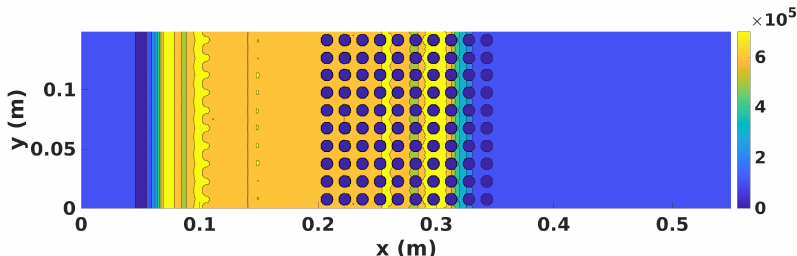
Figure 6. Reference pressure field (Pa) - t = 4 × 10 − 5 s.